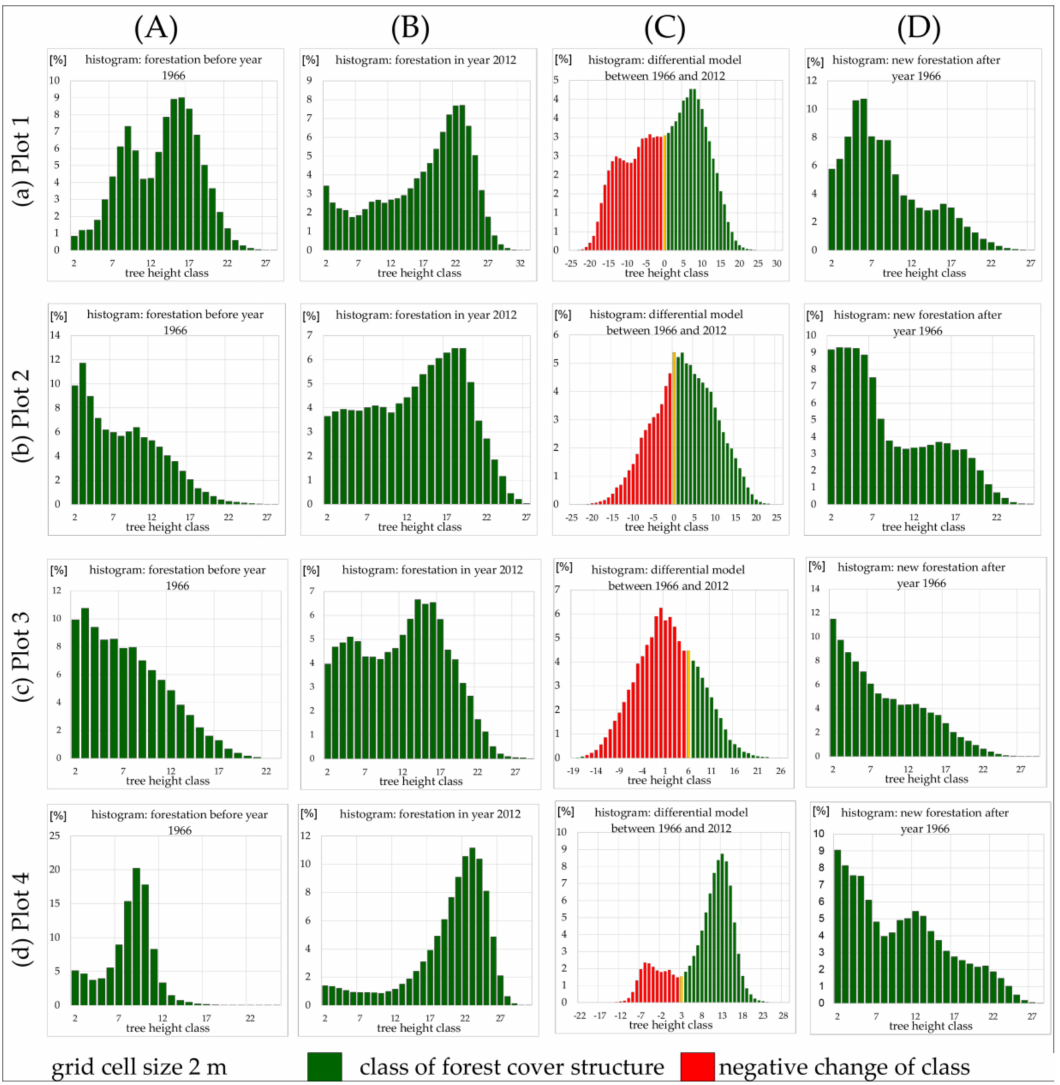
Figure 6. Histograms of a ff orestation height structure for plots developed with the use of grid cell size equal to 2